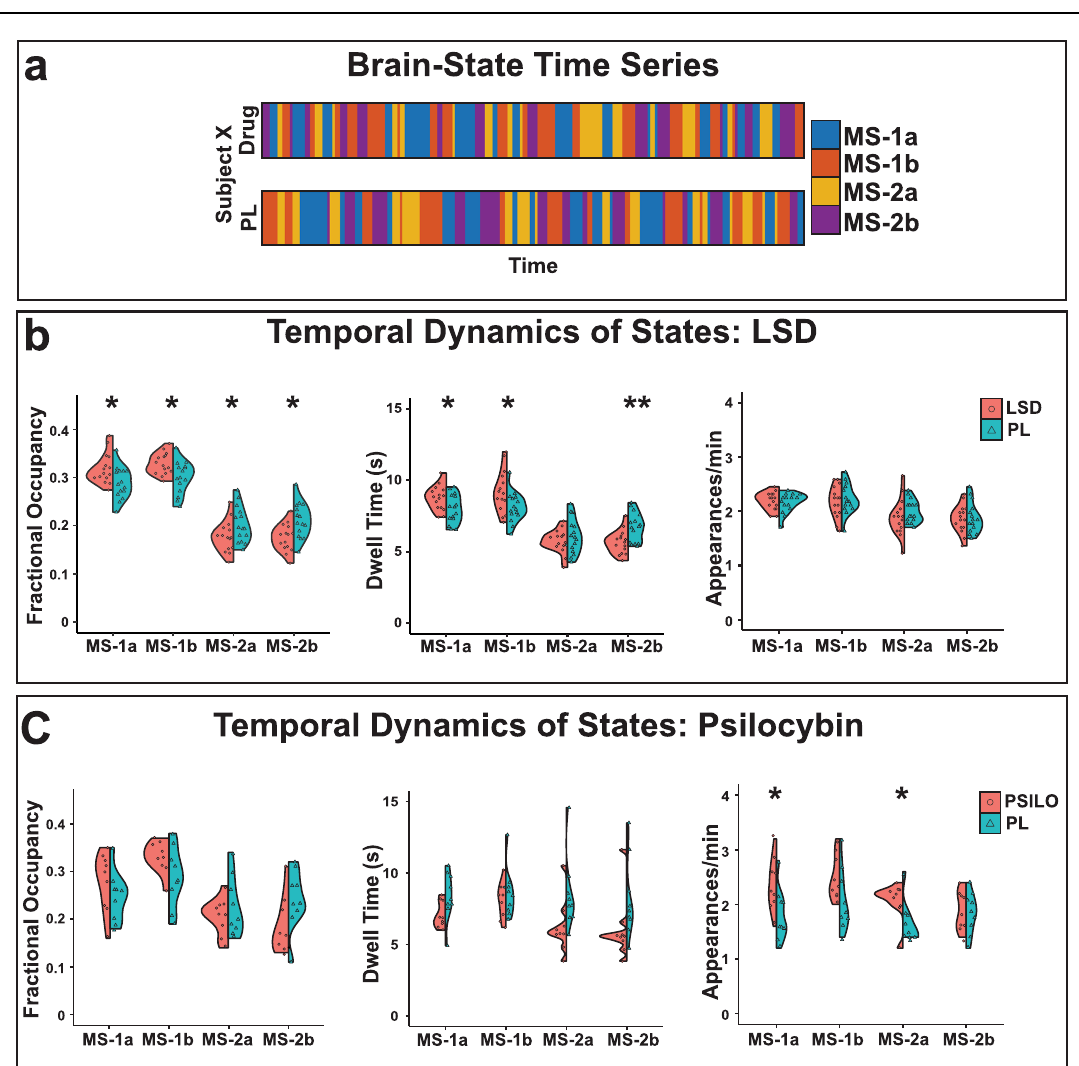
Fig. 3 | Temporalbrain dynamicsshift under psychedelics.a k -means clustering of the BOLD time series resulted in a brain state time series for each of the indivi- duals ’ twoscans 29 .Wethencalculatedeachbrainstates ’ (left)fractionaloccupancy, (center)averagedwelltime,and(right)averagenumberofappearancesperminute